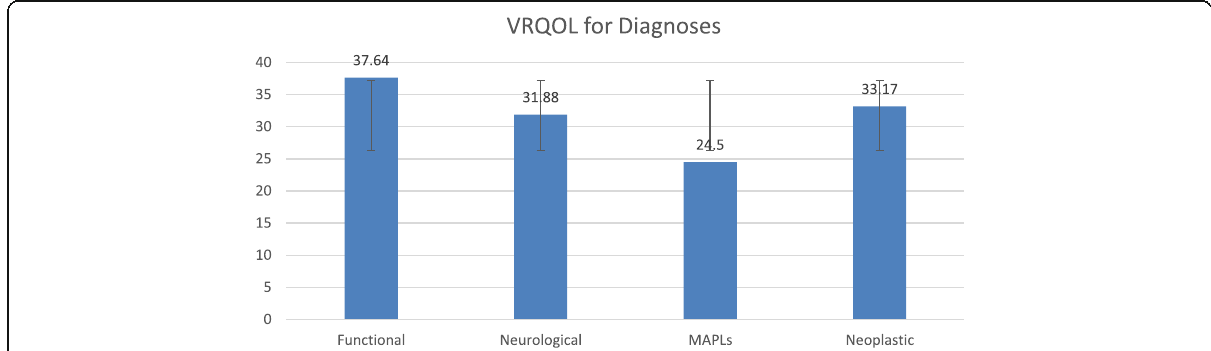
Fig. 3 Comparison of different voice disorders by V-RQOL. There were significant differences in the V-RQOL total scores between functional voice disorders, MAPLs, neoplastic lesions, and neurological